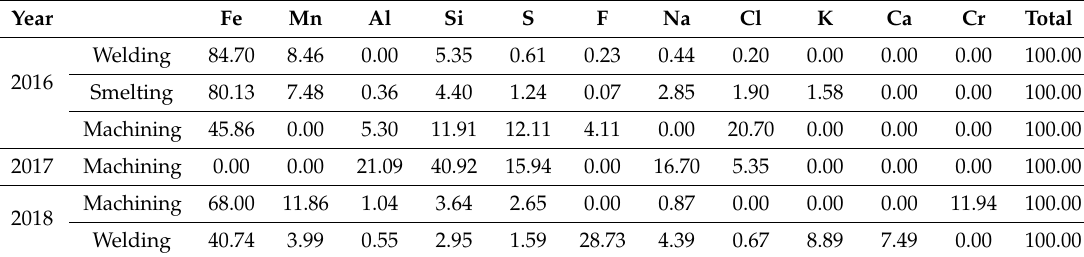
Table 6. Mass percentage of selected elements smaller than 100 nm in the years